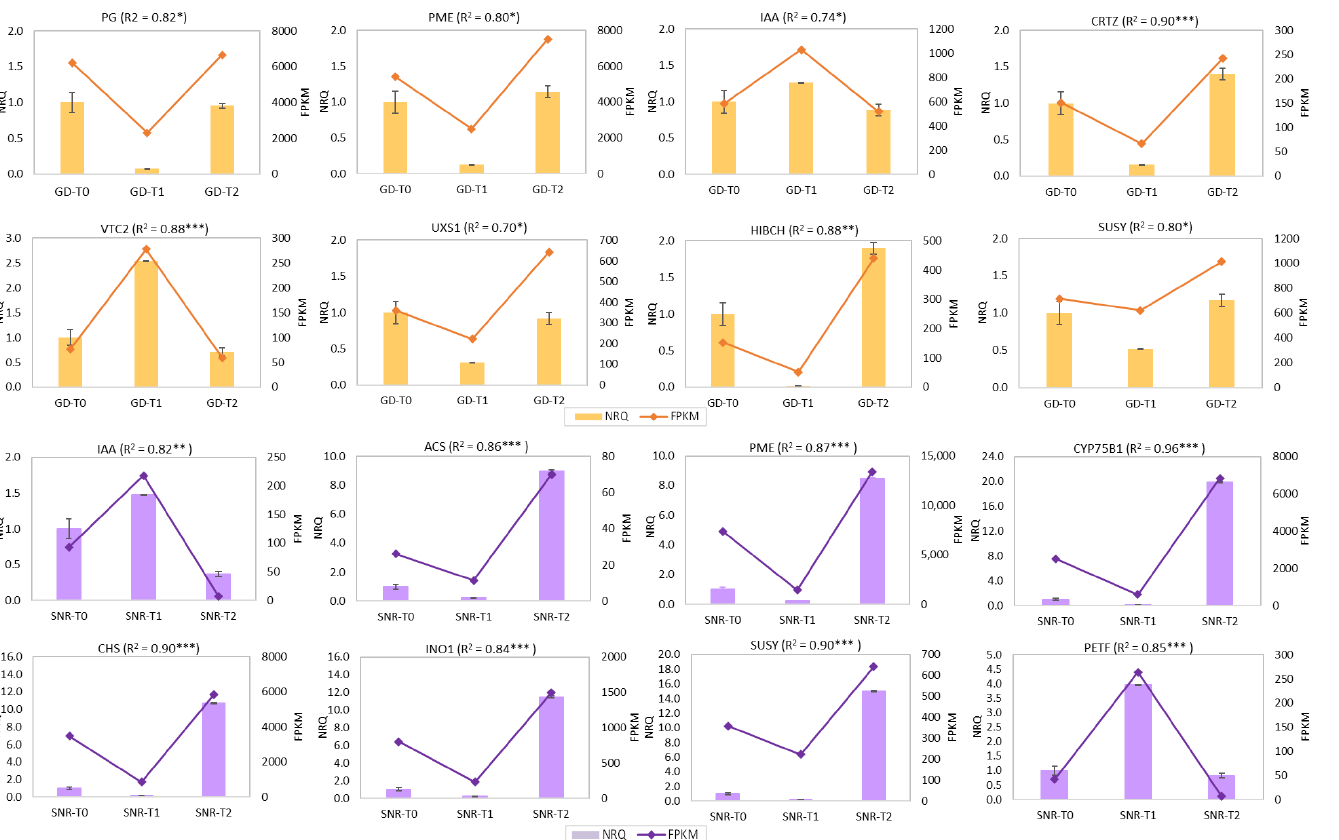
Figure 8. RNAseq validation using NRQ (Normalized Relative Quantification) by RT-qPCR and FPKM (Fragment per Kilobase Million) of 16 genes using three biological and two technical replicates. The orange color shows 8 genes validated in apricot ‘Goldrich’: polygalacturonase (PG), pectinesterase (PME), auxin-responsive protein (IAA), beta-carotene 3-hydroxylase (CRTZ), GDP-L-galactose phosphorylase (VTC2_5), UDP-glucuronate decarboxylase (UXS1), 3-hydroxyisobutyryl-coa hydrolase (HIBCH), and sucrose synthase (SUSY); while purple color shows 8 genes validated in Japanese plum ‘Santa Rosa’: auxin-responsive protein (IAA), pectinesterase (PECT), 1-aminocyclopropane-1-carboxylate synthase (ACS), ferredoxin (PET’), flavonoid 3’-monooxygenase (CYP75B1), chalcone synthase (CHS), inositol phosphate metabolism (INO1), and sucrose synthase (SUSY). In brackets, Pearson correlation is shown ( p -value < * 0.05, ** 0.01, *** 0.005). PME, IAA, and SUSY were exclusively designed using sequences of ‘Goldrich’ and ‘Santa Rosa’ independently.